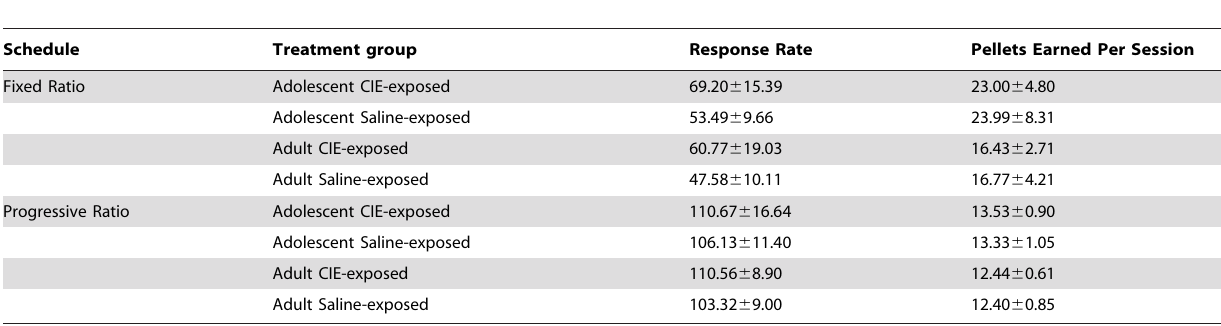
Table 2. Response rate (responses/min) and Pellets earned per session in the final 5 sessions of both the Fixed Ratio 10 TO 20 s and Progressive Ratio experiments.